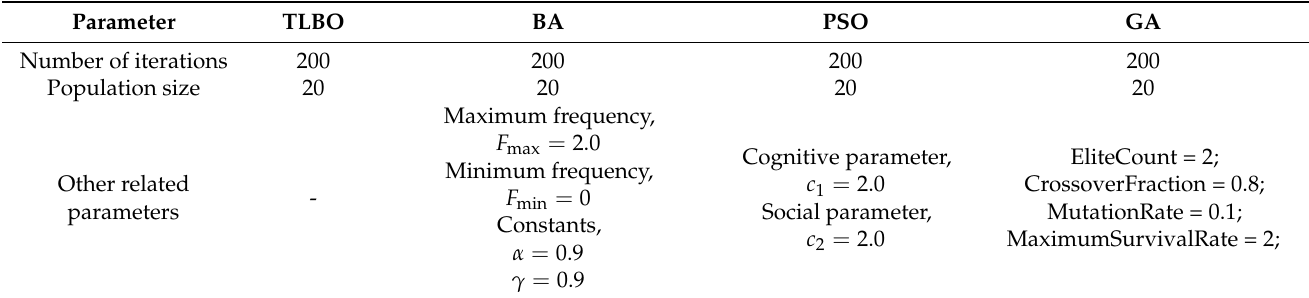
Table 6. Parameters of the other optimization